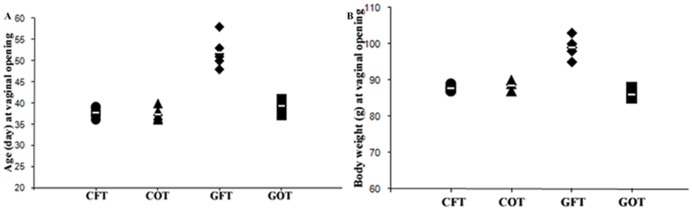
The timing of vaginal opening.Onset of puberty, as marked by the day of vaginal opening, in different groups of rats is presented with respect to age (4A) and body weight (4B). Transplantation of neither fat (CFT), nor ovary (COT) impacts the day of vaginal opening in the control group. But as compared to CFT and COT, the fat transplanted sub-group of the GalTase-exposed rats (GFT) exhibit significantly (P<0.0001) delayed vaginal opening. The timing of vaginal opening, however, is significantly (P<0.0001) advanced in the ovary-transplanted rats of the GalTase-exposed group (GOT). Due to delayed onset of puberty, the body weight on the day of VO is significantly higher in the GFT group with respect to all other groups (P<0.0001). Values are presented as individual datum with mean.